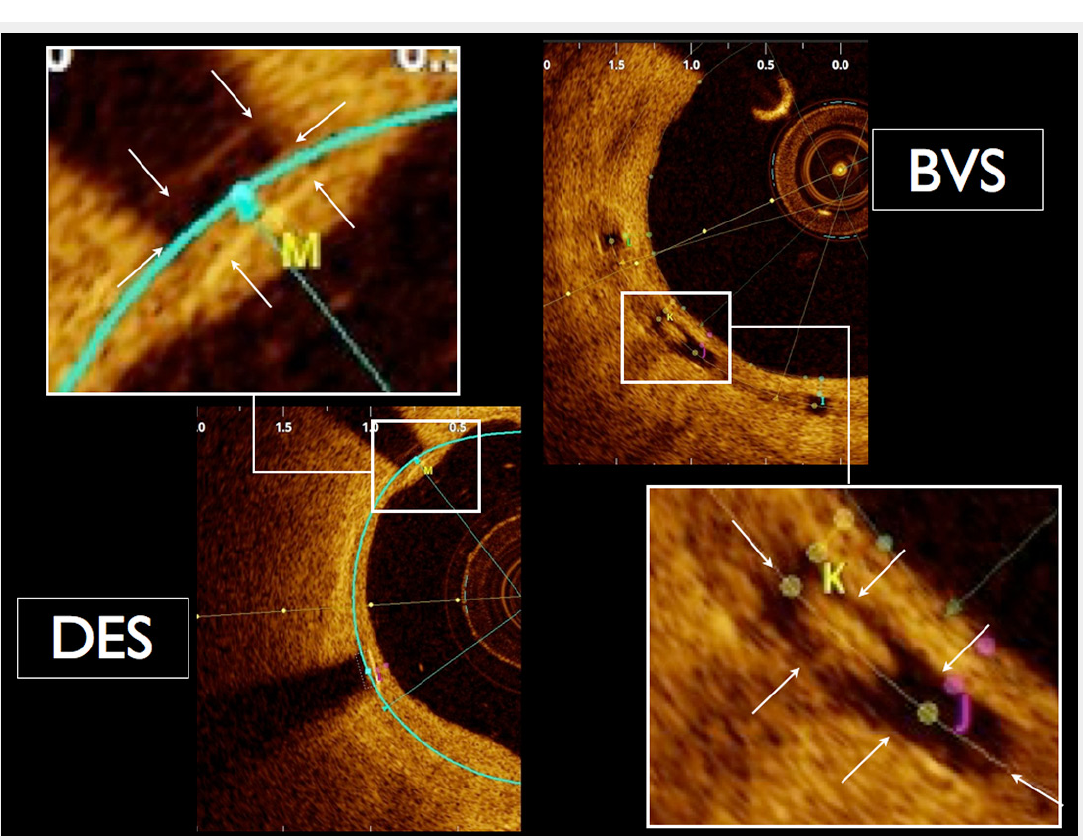
Figure 1 Representative images of OCT analysis of BVS and DES. This image shows the analysis of stent/scaffold area. After identifying all struts in a cross-section, stent/scaffold area was delineated by a curvilinear interpolation connecting the middle points of the struts at mid-strut depth. BVS = bioresorbable vascular scaffold; DES = drug-eluting stent; OCT = optical coherence